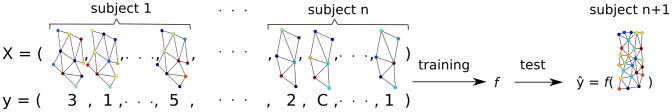
Inter-subject graph-based learning. Equipped with a graph construction scheme and a graph similarity function such as those designed in this paper, one can define numerous classifiers.The decision function f is learnt on a training set composed of labelled graphs (Xi, yi), with  from a set of subjects, and can be used on graphs from another subject, potentially with a different number of nodes. We here use support vector machines to demonstrate the soundness of this approach when dealing with inter-subject variability of fMRI activation patterns.